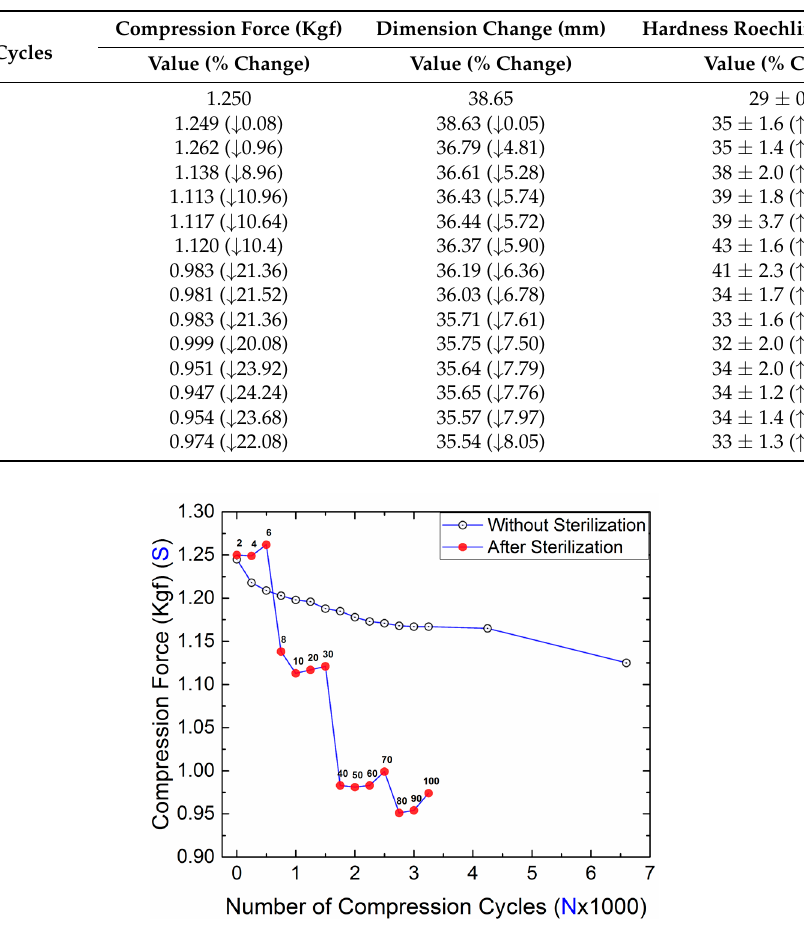
Figure 2. Plot between the compression force and the number of compression cycles of the clip with and without sterilization cycles.